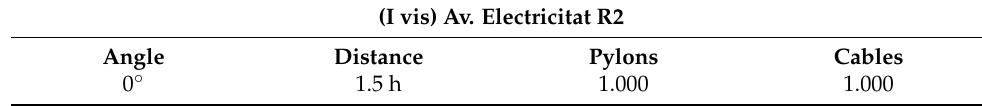
Table 11. Visibility index of the Avinguda Electricitat application case.